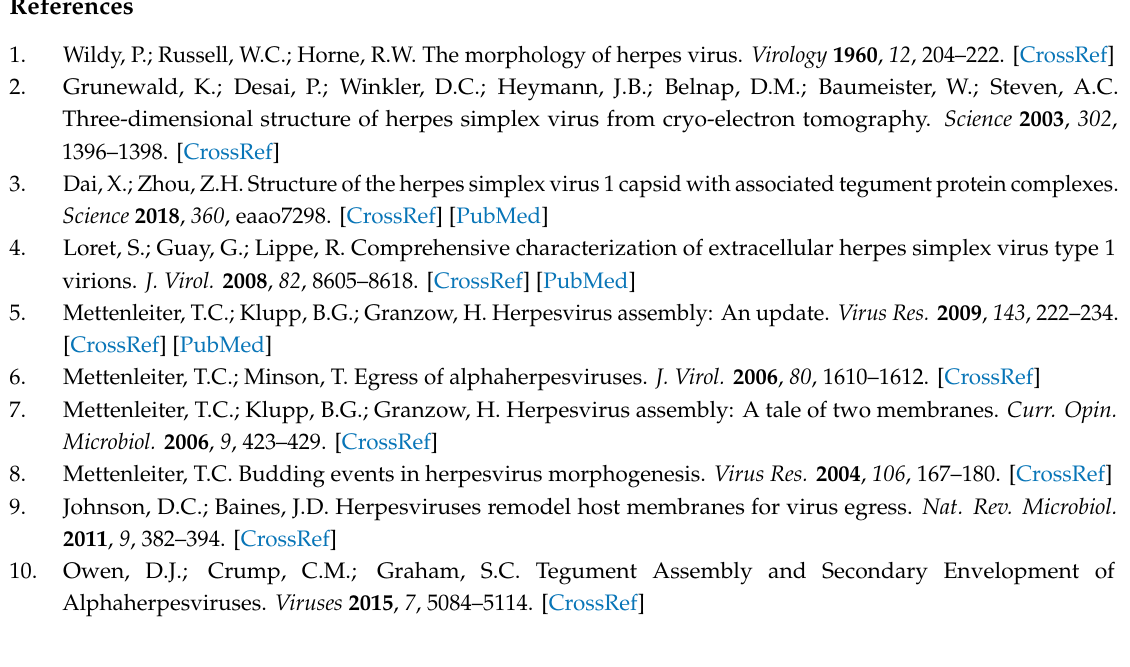
Figure S1: Plating efficiency of mutant viruses following marker-rescue / marker-transfer transfections.; Figure S2: Truncations of pUL37 lead to a defect in cytoplasmic envelopment of virus particles; Figure S3: pUL37 alanine-scanning mutants (AAA) target conserved residues in the C-terminal half of the polypeptide.; Table S1: Primer